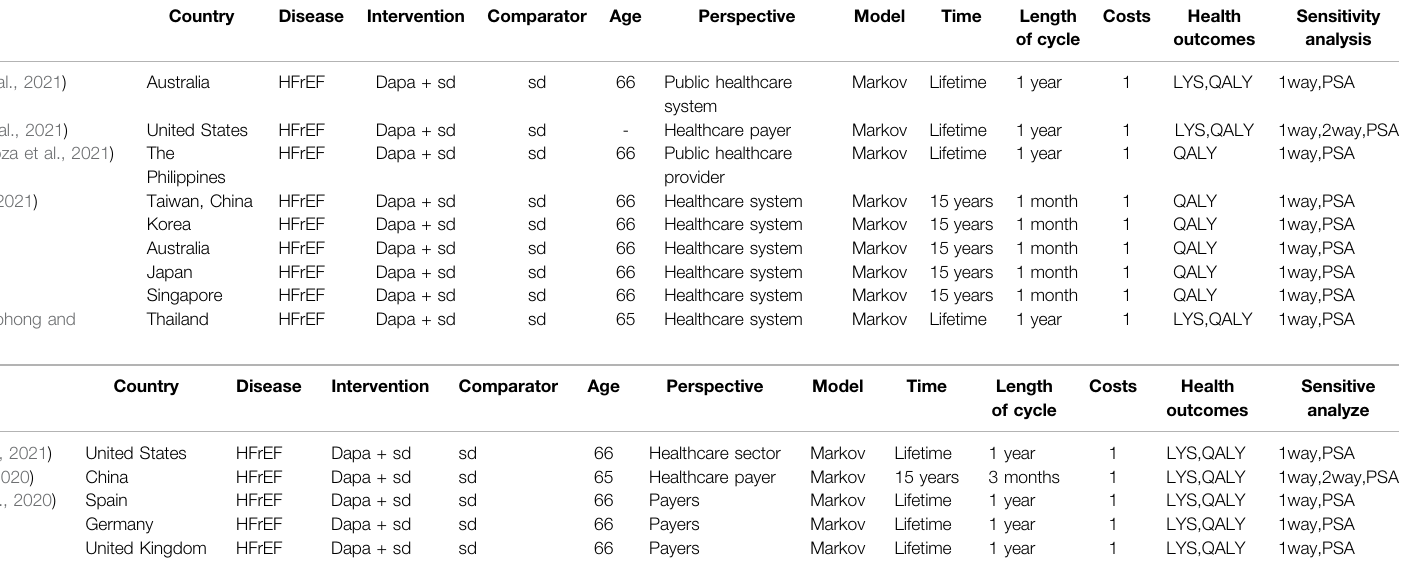
TABLE 1 | Summary of included studies